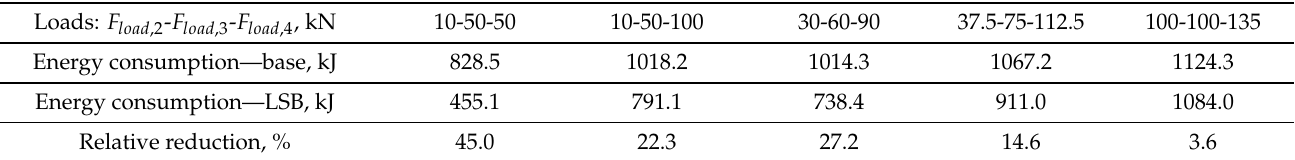
Table 4. Energy consumption, different load forces.